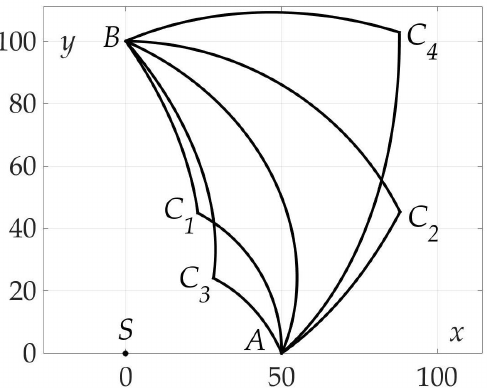
Figure 18. Optimal trajectory on Cartesian plane.